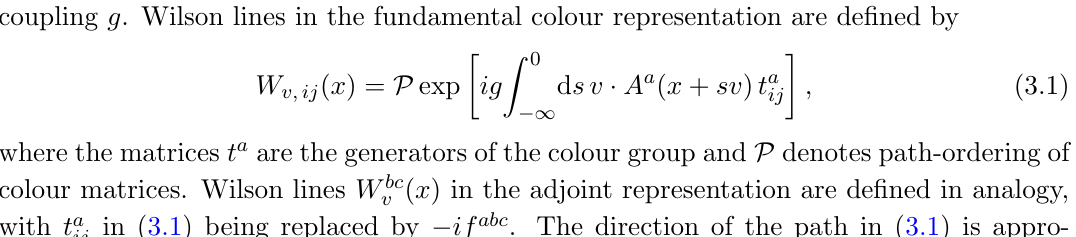
Figure 4 . Feynman rules for eikonal lines in the fundamental representation of the colour group. coupling g . Wilson lines in the fundamental colour representation are de(cid:12)ned